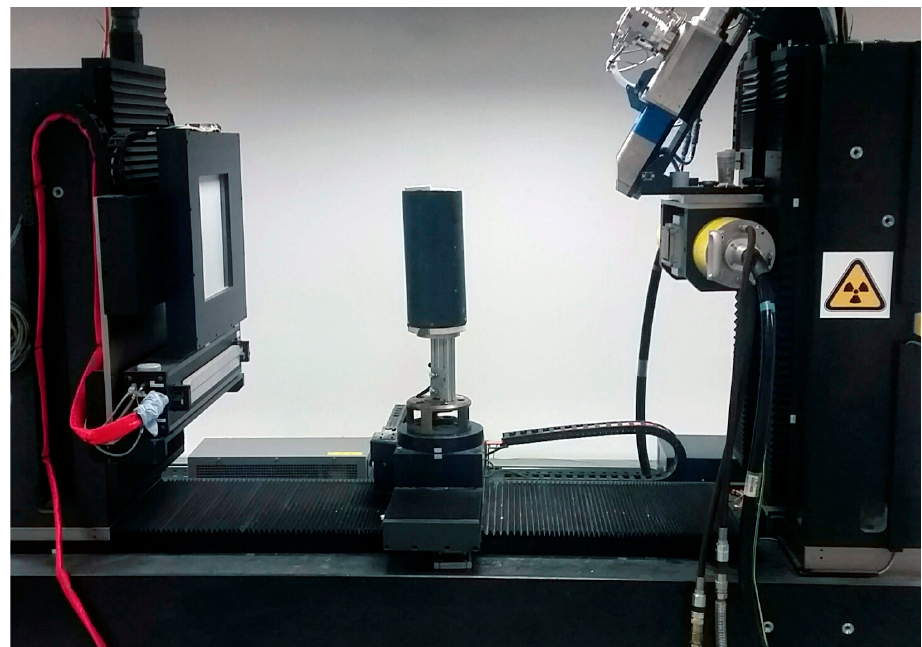
Figure 5. From left to right: Computed tomography setup with a flat panel detector, the test cylinder, and the x-ray tube.